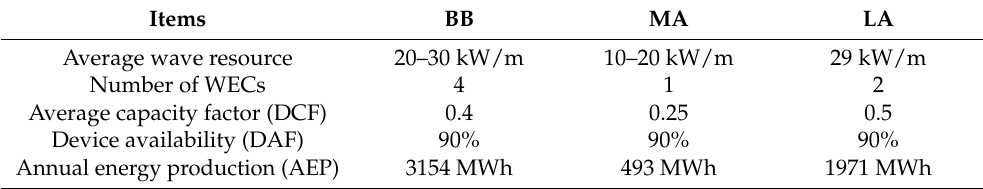
Table 7. Some key assumptions of the proposed WEC configurations.